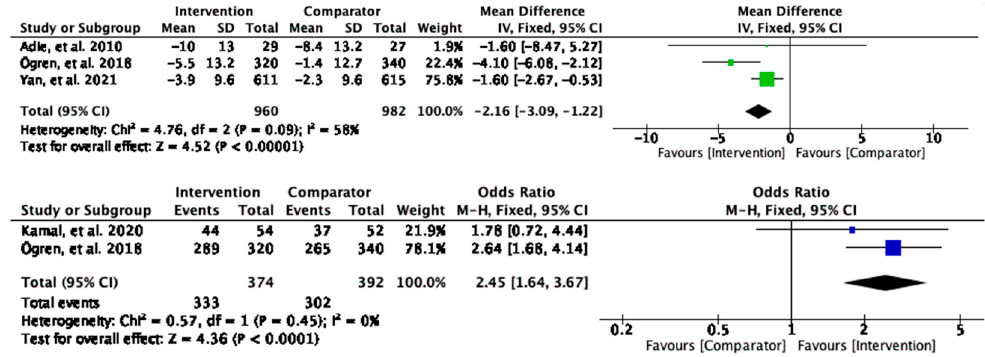
Figure 5. Meta-analysis results of intervention effects on diastolic blood pressure.